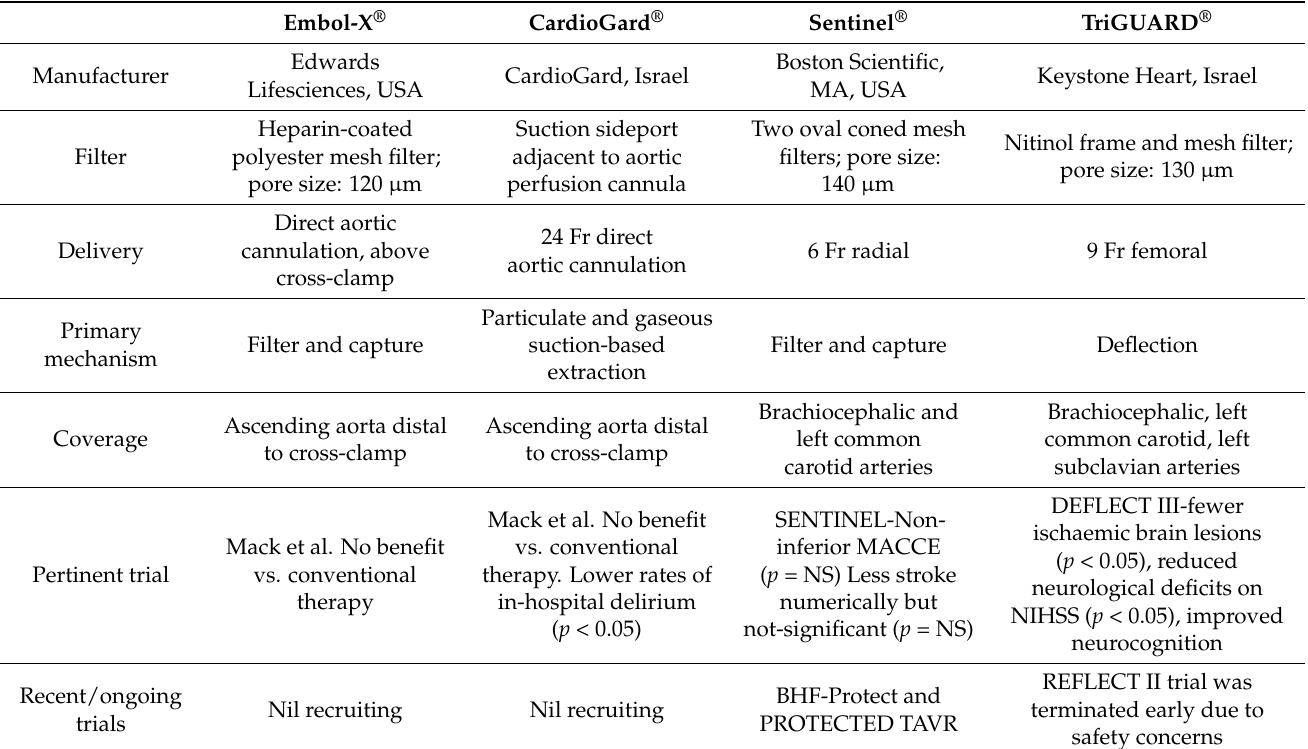
Table 3. Cerebral embolic protection